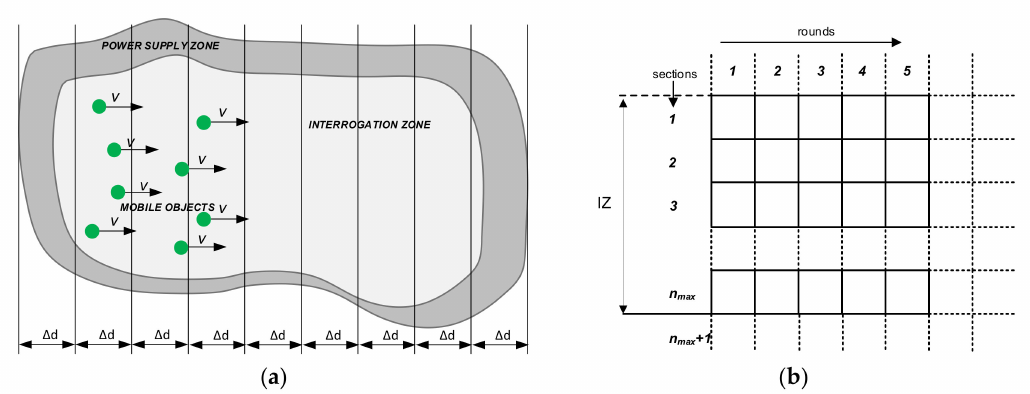
Figure 7. Representation of dynamic RFID system: ( a ) power supply zone (PSZ) in discrete form—divided into individual sections; ( b ) the general structure of matrices used to describe the state of the RFID